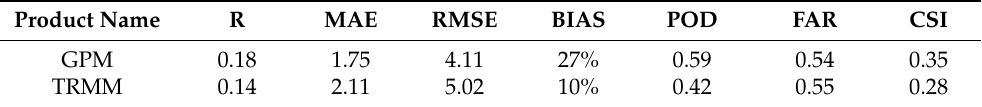
Table 3. The average values of seven evaluation metrics for the GPM and TRMM at the grid